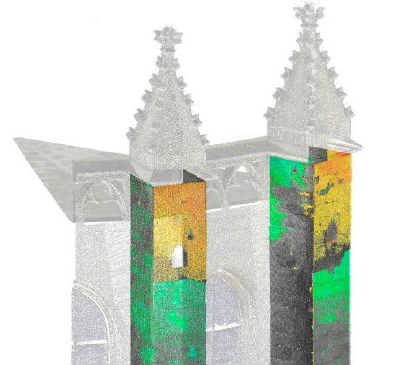
Figure 13: Coincident flatness anomaly in the two upper